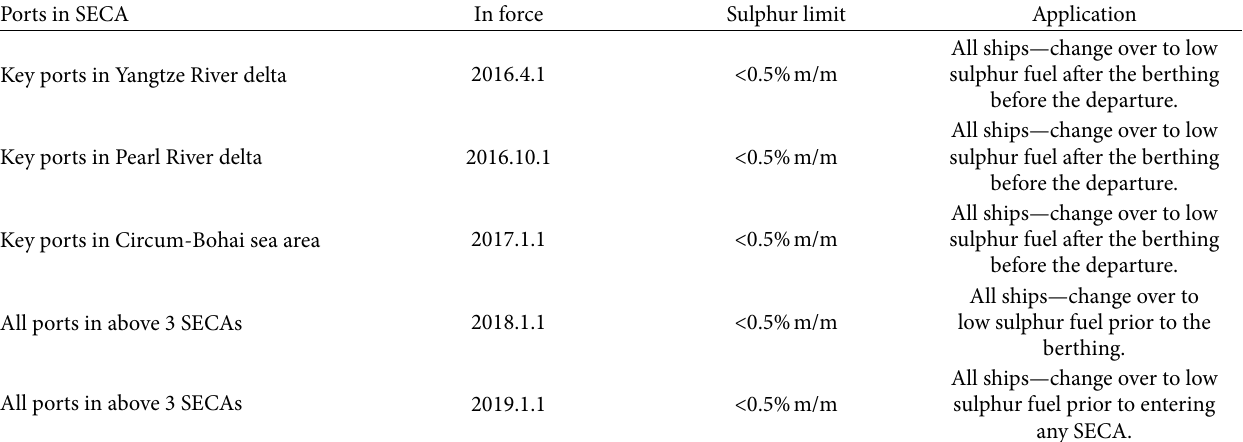
emissions control in China x